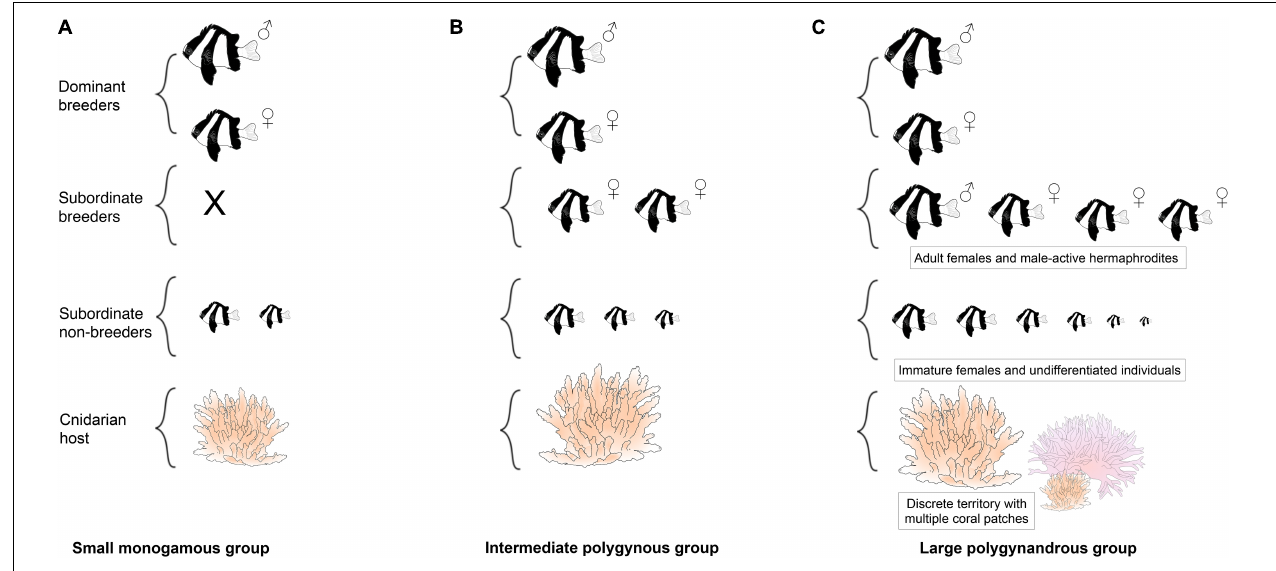
FIGURE 2 | Schematic of the variable social organization (A–C) of Dascyllus aruanus . X denotes no individuals present at that